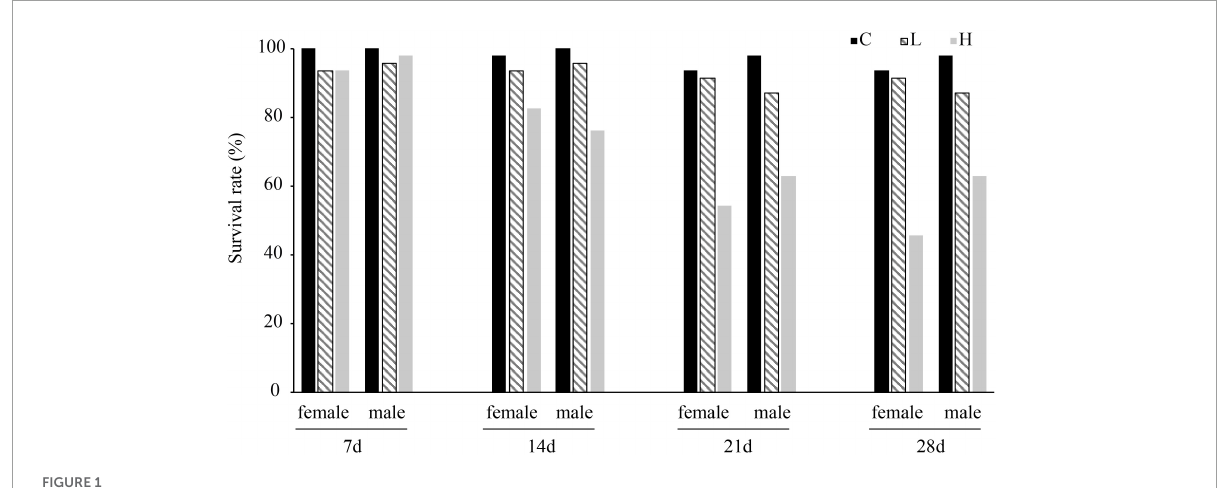
FIGURE1 Survival rate of female and male Pomacea canaliculata at different temperature and treated time.